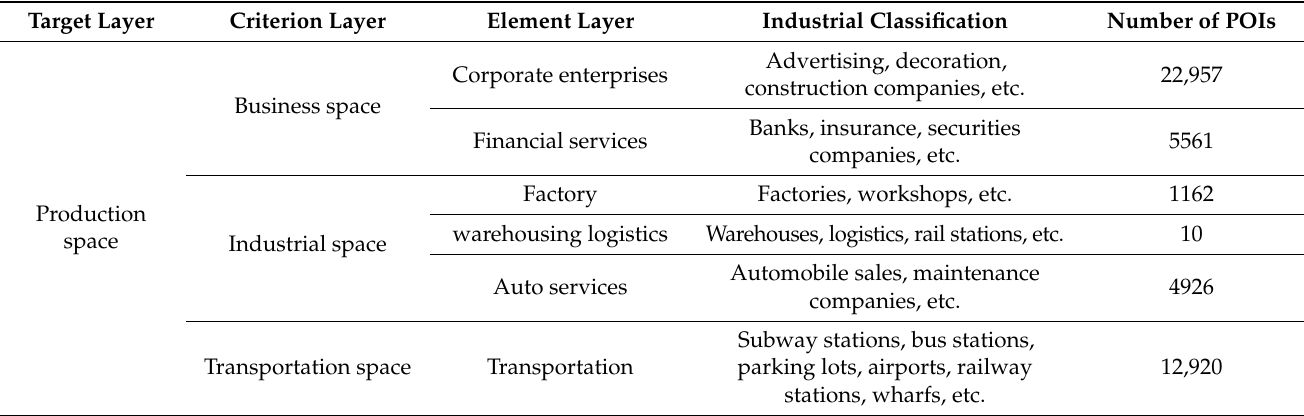
Table 1. Urban “production–living–ecological” space POI data classification system.